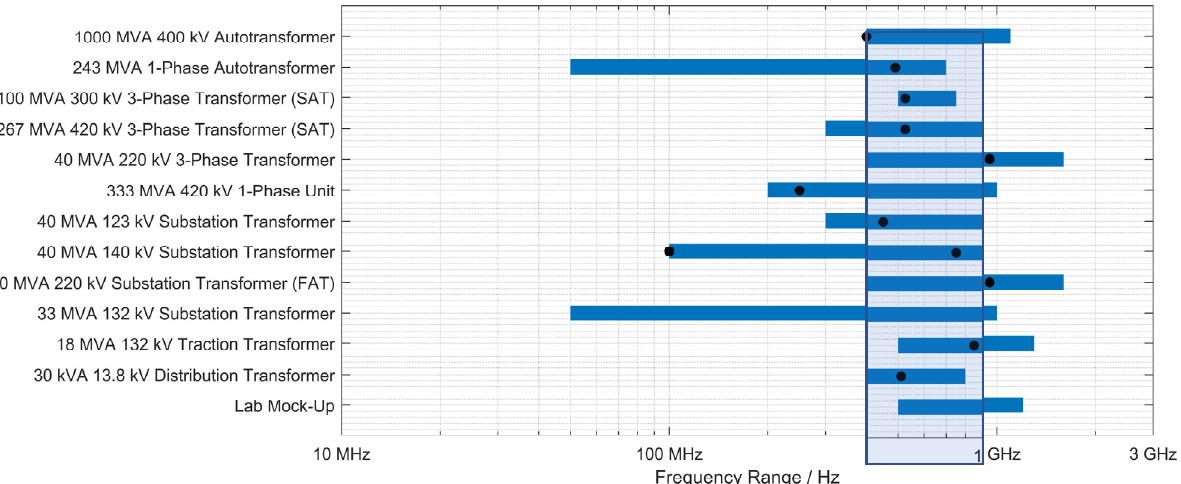
Figure 25. Overview of frequency spectra of presented use cases; black dots indicate peak frequency.